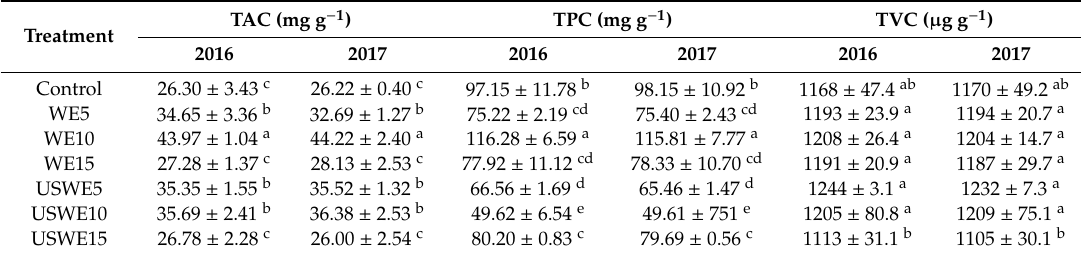
Figure 5. DPPH inhibition (% inhibition) of Jew’s Mallow with water extract (WE) and ultrasound-assisted water extract (USWE) in the 2016 and 2017 growing seasons. Different letters (a, b, etc.) above bars indicate a significant difference among treatments in each season. Table 5. E ff ects of water extract (WE) and ultrasound-assisted Water Extraction (USWE) on total antioxidant content (TAC), total phenolic content (TPC), and total flavonoid content (TVC) of Jew’s Mallow during the 2016 and 2017 growing